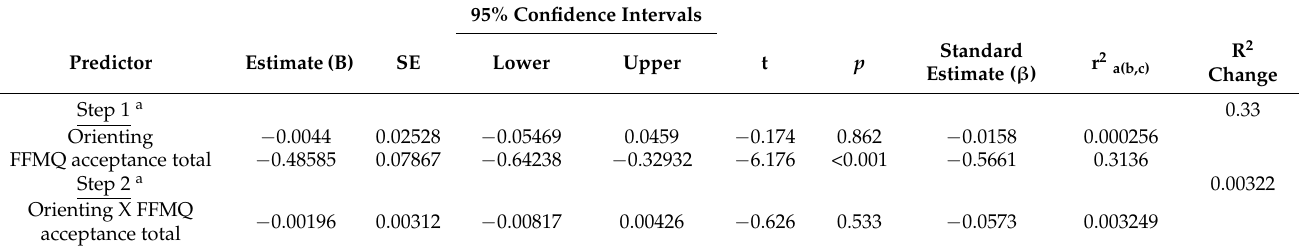
Table 5. Moderation model results for the prediction of Chronic Stress (i.e., PSS score) from Orienting (i.e., orienting coefficient) moderated by Acceptance (i.e., combination of the FFMQ acceptance subscales